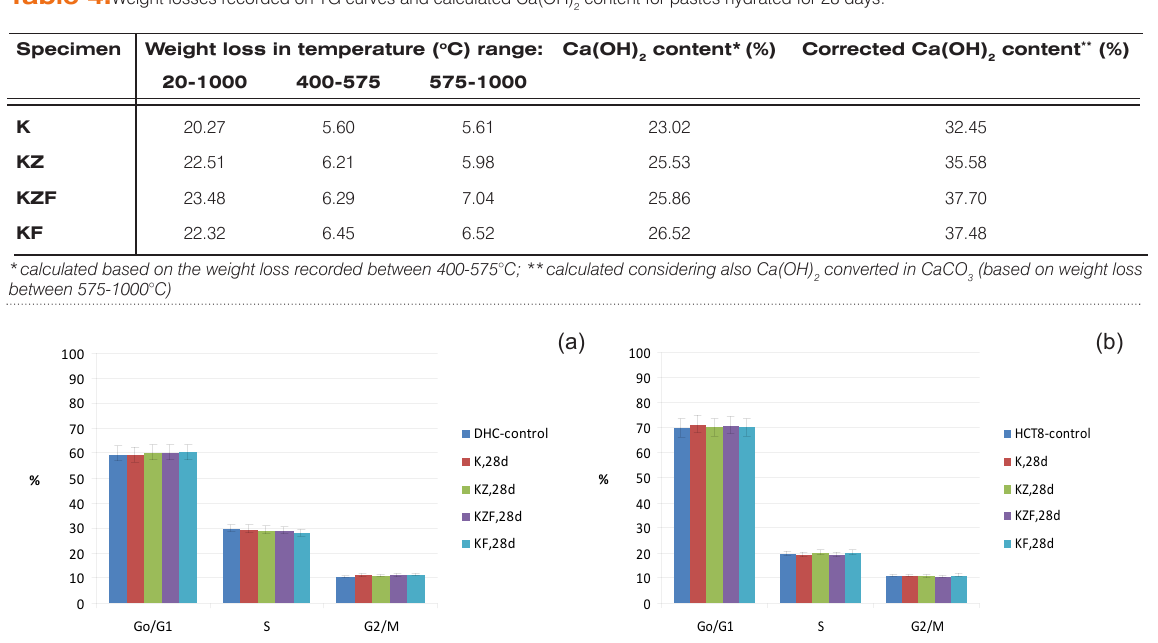
Table 4. Weight losses recorded on TG curves and calculated Ca(OH) Specimen Weight loss in temperature ( o C) range: Ca(OH)